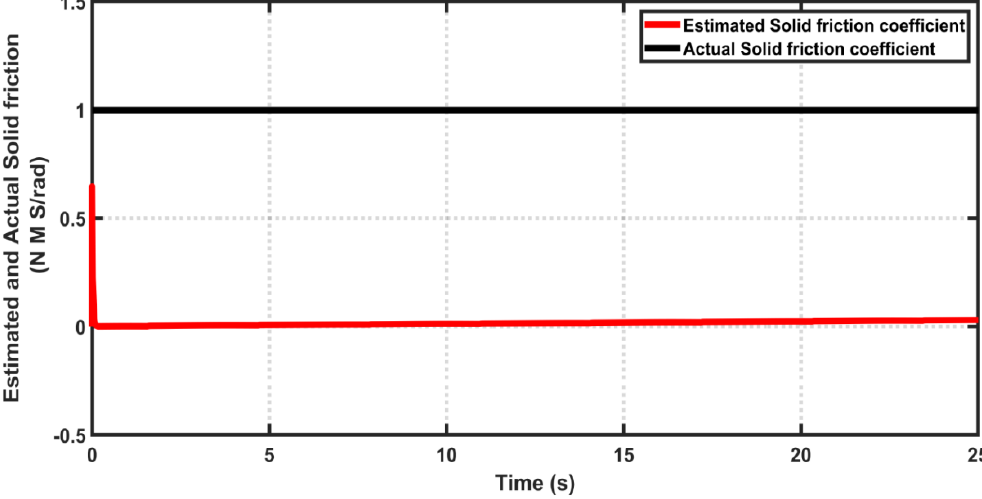
. . . 𝑓𝑓 𝑠𝑠 𝑓𝑓 𝑠𝑠 𝑓𝑓 𝑠𝑠